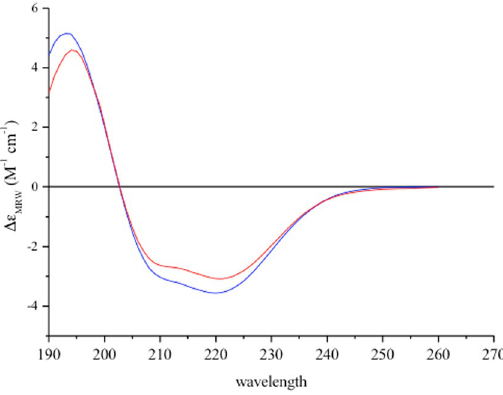
Figure 2. Far-UV CD spectrum of HydF taken before (blue) and immediately after (red) addition of